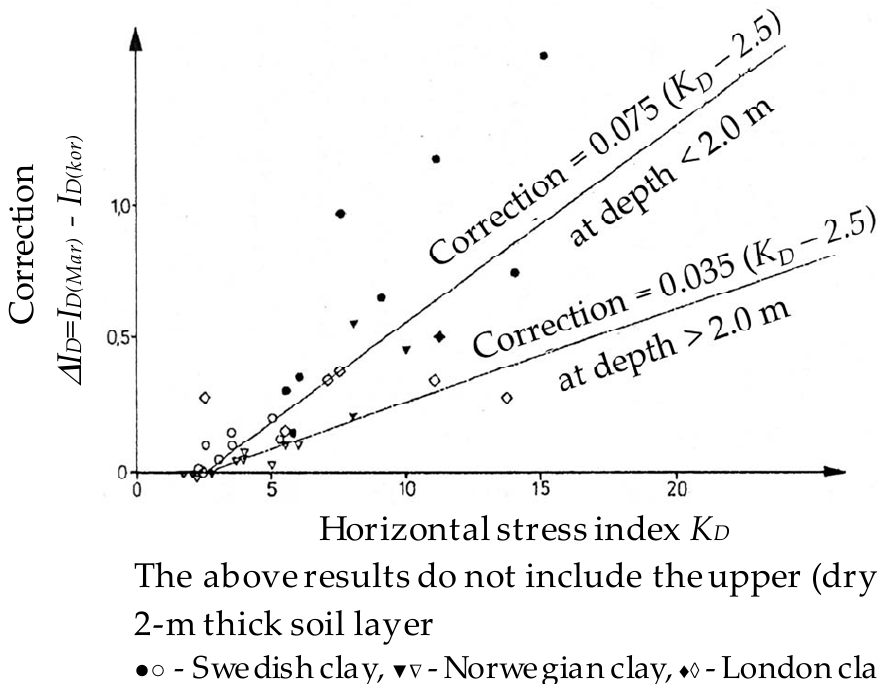
Figure 3. Difference between material index ( I D ( Mar ) ) and material index I D ( kor ) for different clay content depending on the horizontal stress index K D [7].